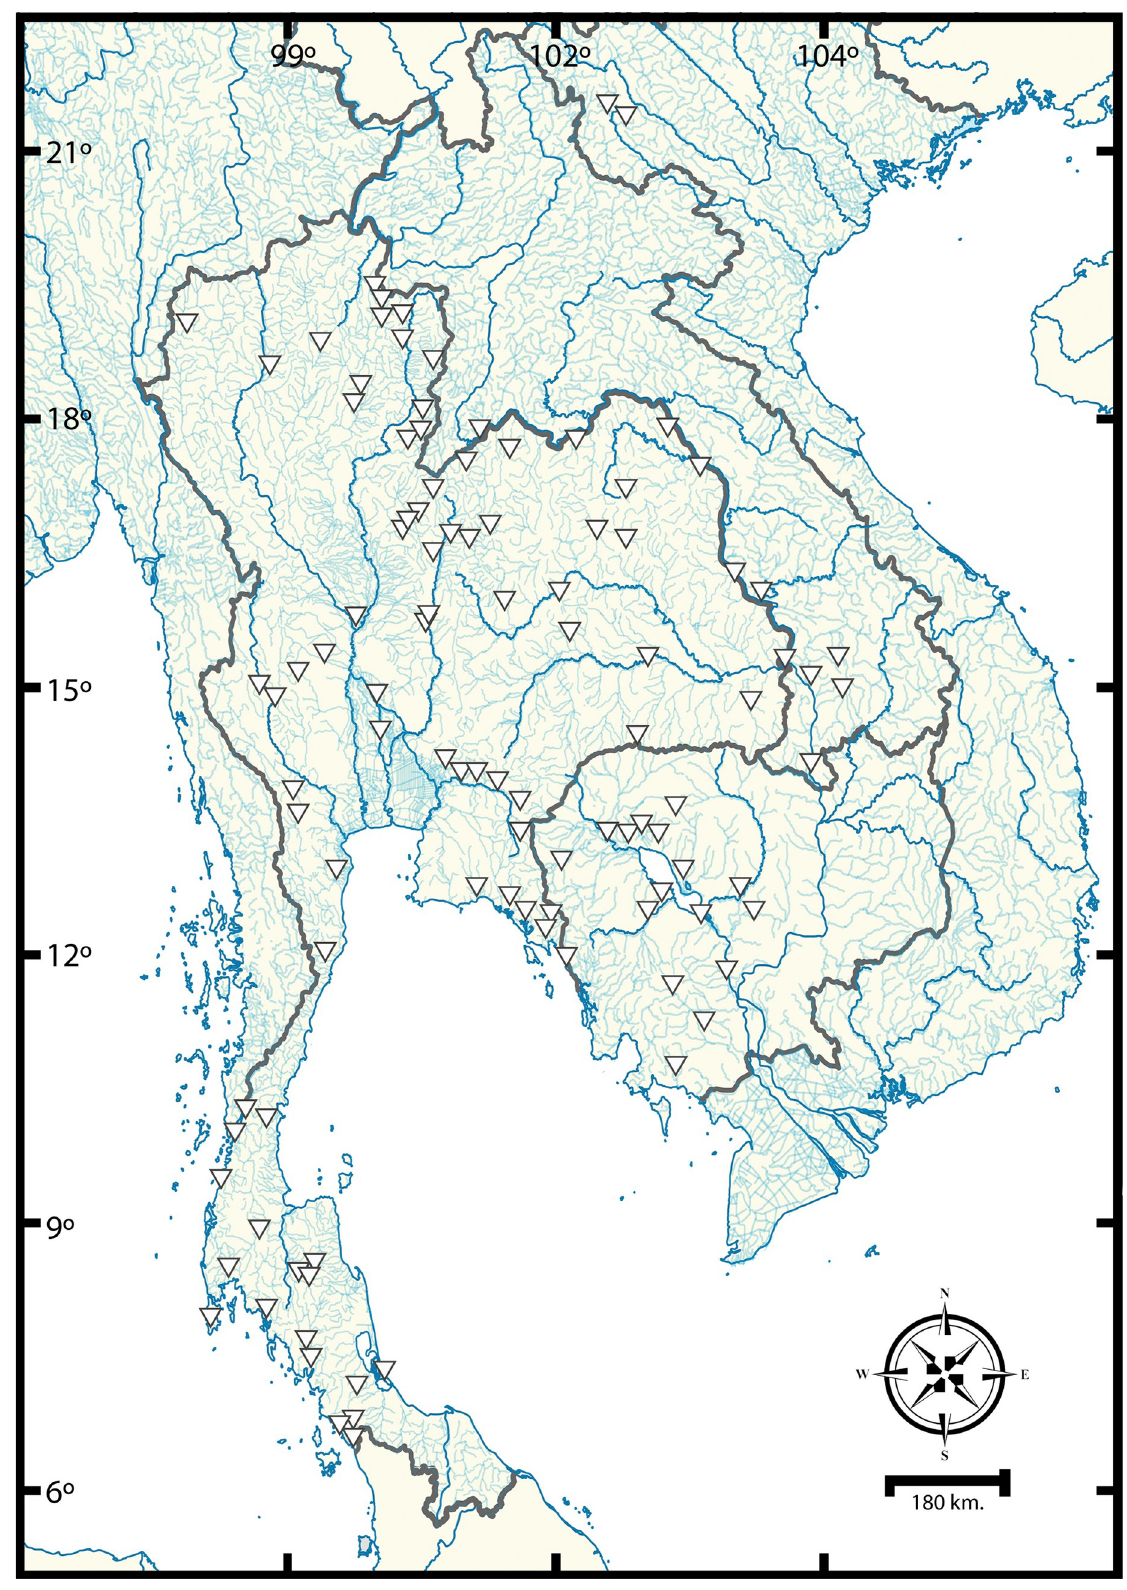
Fig 1. Sampling localities of Macrobrachium in the Indochinese subregion. https://doi.org/10.1371/journal.pone.0252546.g001 PLOS ONE | https://doi.org/10.1371/journal.pone.0252546 June 2,